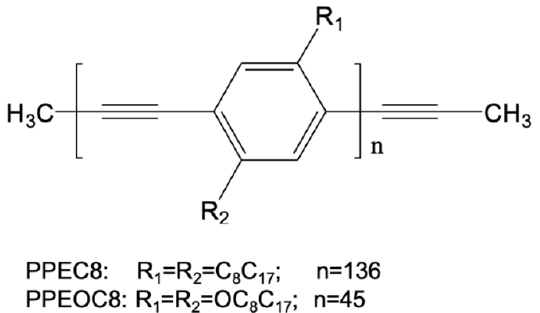
Table 1. Maximum solubility (mg/mL) of SWNTs in various solvents by PPE wrapping (a) . Polymer DCB